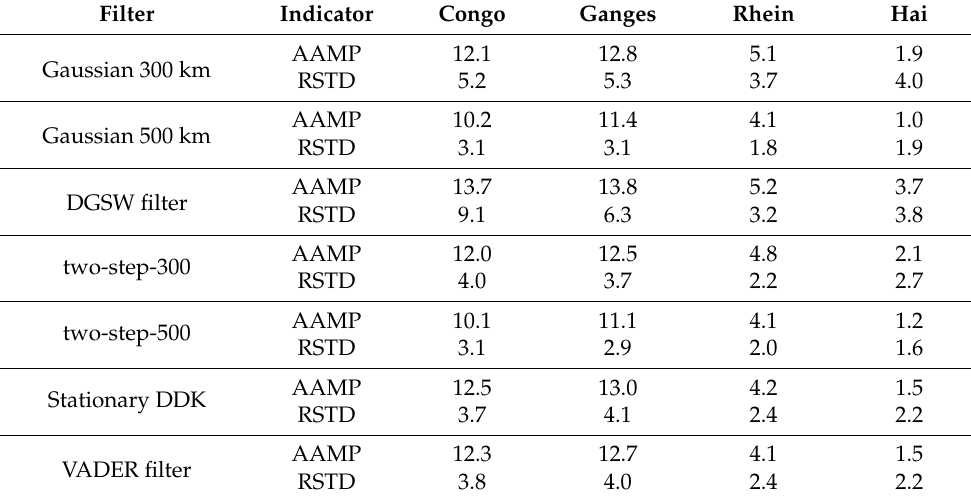
Figure 13. Residuals STD of filtered global mass anomaly from January 2004 to December 2010. To obtain the residuals, the constant, trend, annual, and semiannual signal terms are deducted from the filtered solutions. The noise STDs averaged over the entire ocean are: unfiltered (23.4 cm), Gaussian 300 km (3.7 cm), Gaussian 500 km (1.5 cm), DGSW (5.2 cm), two-step-300 filter (1.9 cm), two-step- 500 filter (1.4 cm), stationary DDK (2.0 cm), VADER (2.1 cm), adaptive DDK (2.1 cm) and mascon (2.1 cm), respectively. Table 4. The regional average annual amplitude (AAMP) and residual STD (RSTD) of filtered mass anomaly solutions at Congo Basin, Ganges Basin, Rhein Basin, and Hai River Basin. The results are based on data from January 2004 to December 2010, and presented in EWH